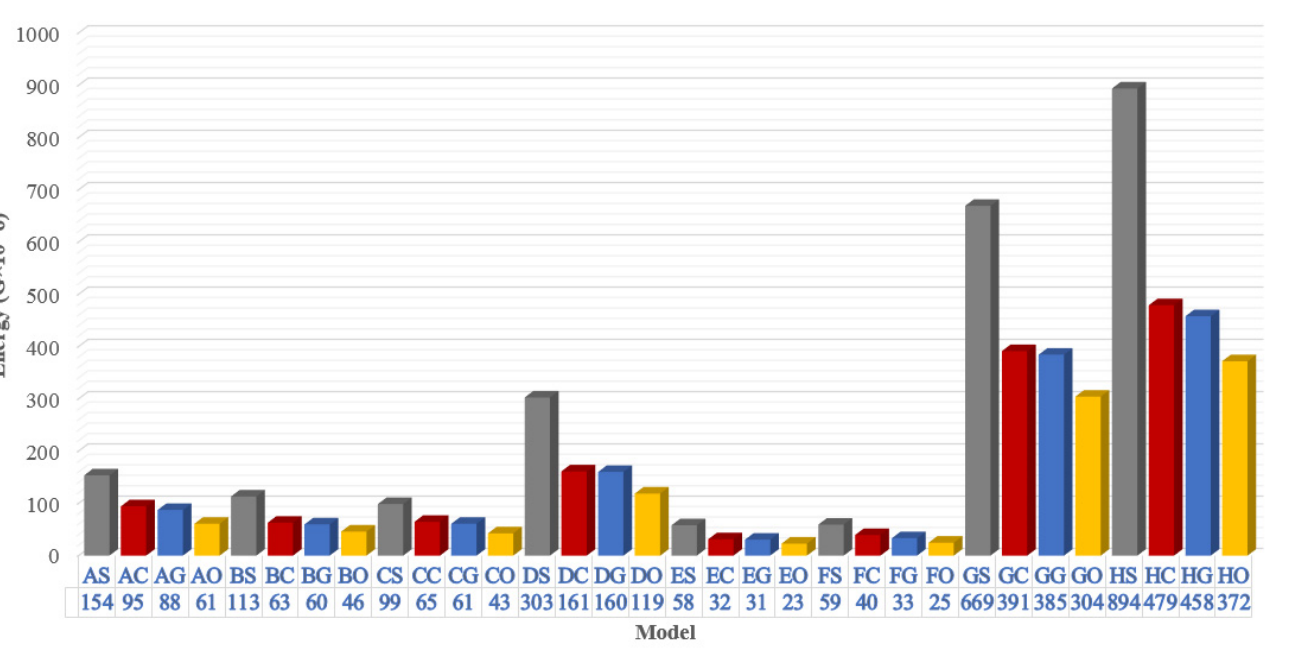
Figure 15. Energy absorption of the models .